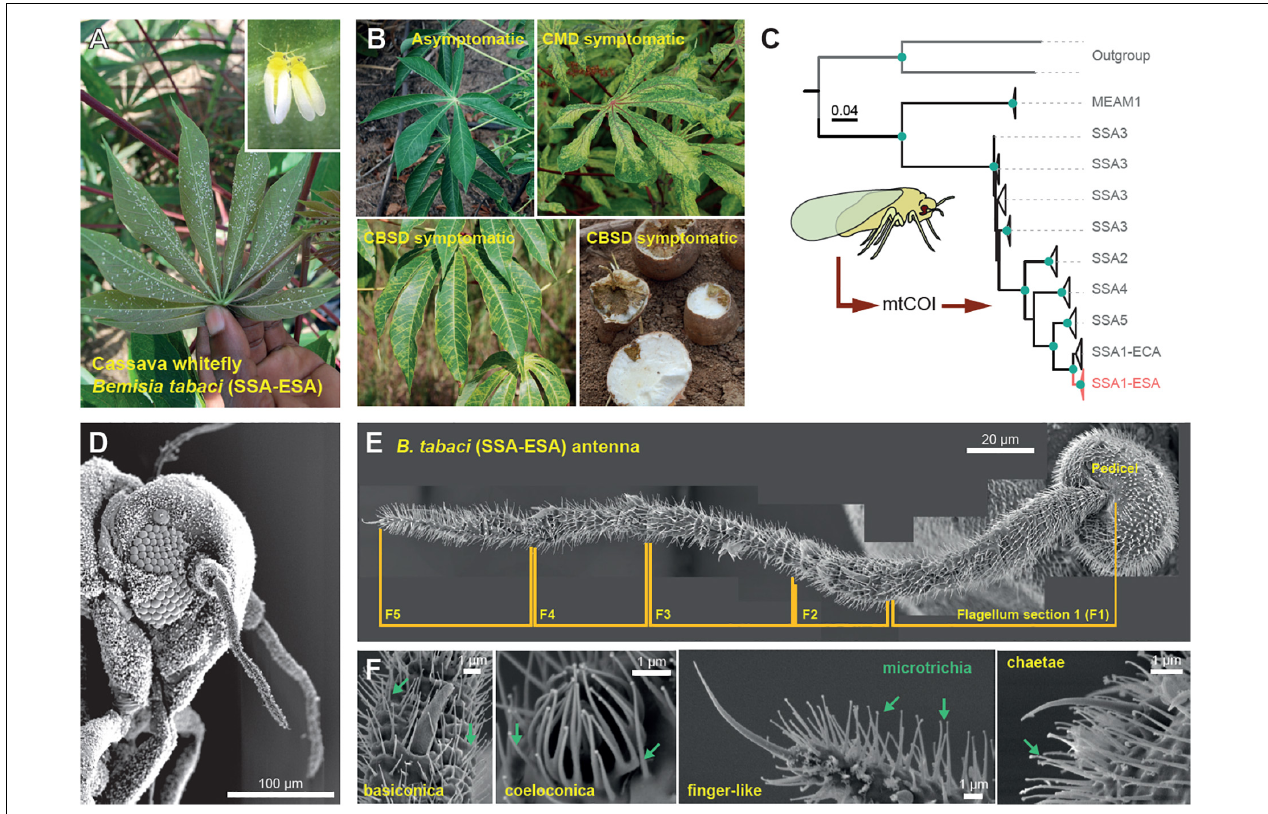
FIGURE 1 | The cassava whitefly Bemisia tabaci . (A) The cassava whiteflies are usually found underneath plant leaves where they feed, mate and reproduce. (B) Symptoms of the viral diseases of cassava (cassava mosaic disease and cassava brown streak disease) transmitted by the cassava whitefly. (C) Maximum-likelihood phylogenetic tree showing the similarities between the 16S mtCOI sequences of the whiteflies from Sub-Saharan Africa (SSA), including the cassava whiteflies found in the Eastern and Southern Africa (SSA-ESA), the cassava whiteflies found in the Eastern and Central Africa (SSA-ECA) and the non-cassava whitefly Middle East Asia Minor (MEAM1). (D) Scanning electron microscopy (SEM) image of the head of the cassava whitefly (210x magnification) showing the position and relative size of the antenna. (E) External structure of the antenna of the cassava whitefly SSA-ESA showing different segments of the flagellum obtained from SEM. (F) Types of olfactory sensilla found on the antenna of the cassava whitefly SSA-ESA obtained from